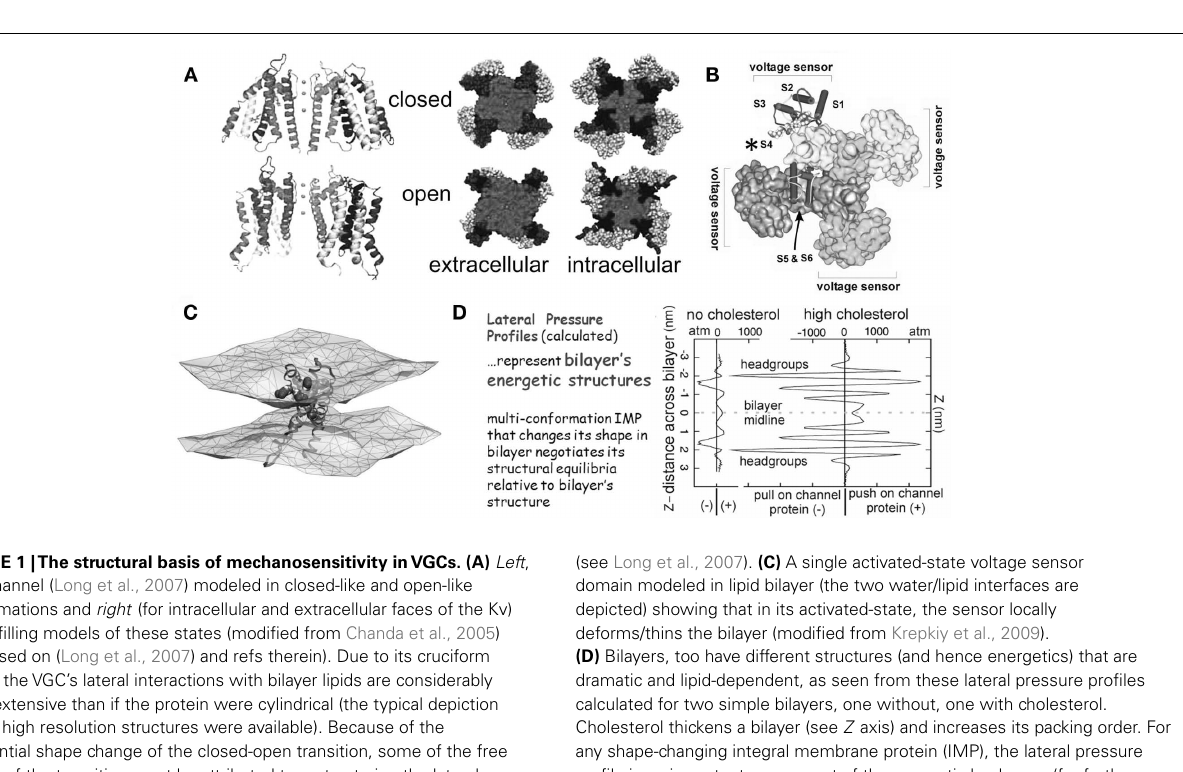
FIGURE 1 |The structural basis of mechanosensitivity inVGCs. (A) Left , a Kv channel (Long et al., 2007) modeled in closed-like and open-like conformations and right (for intracellular and extracellular faces of the Kv) space-filling models of these states (modified from Chanda et al., 2005) and based on (Long et al., 2007) and refs therein). Due to its cruciform shape, theVGC’s lateral interactions with bilayer lipids are considerably more extensive than if the protein were cylindrical (the typical depiction before high resolution structures were available). Because of the substantial shape change of the closed-open transition, some of the free energy of the transition must be attributed to restructuring the lateral protein-lipid interface. (B) The 4 voltage sensors, whose gating charge is primarily in transmembrane segment S4 (asterisk), occupy the periphery